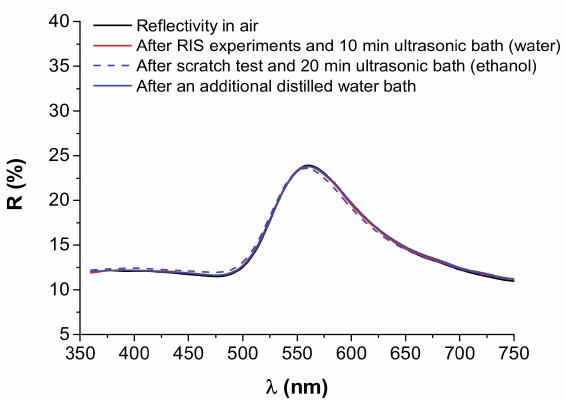
Figure 6. Reflectivity of the thermally annealed 4 nm Au sample (630 ◦ C for 10 h 30 min), compared: in air; after RIS experiments using multiple RI liquids and a 10 min ultrasonic cleaning bath in distilled water; after scratch test and additional 20 min of ultrasonic cleaning bath in ethanol and drying; following an additional distilled water bath and drying